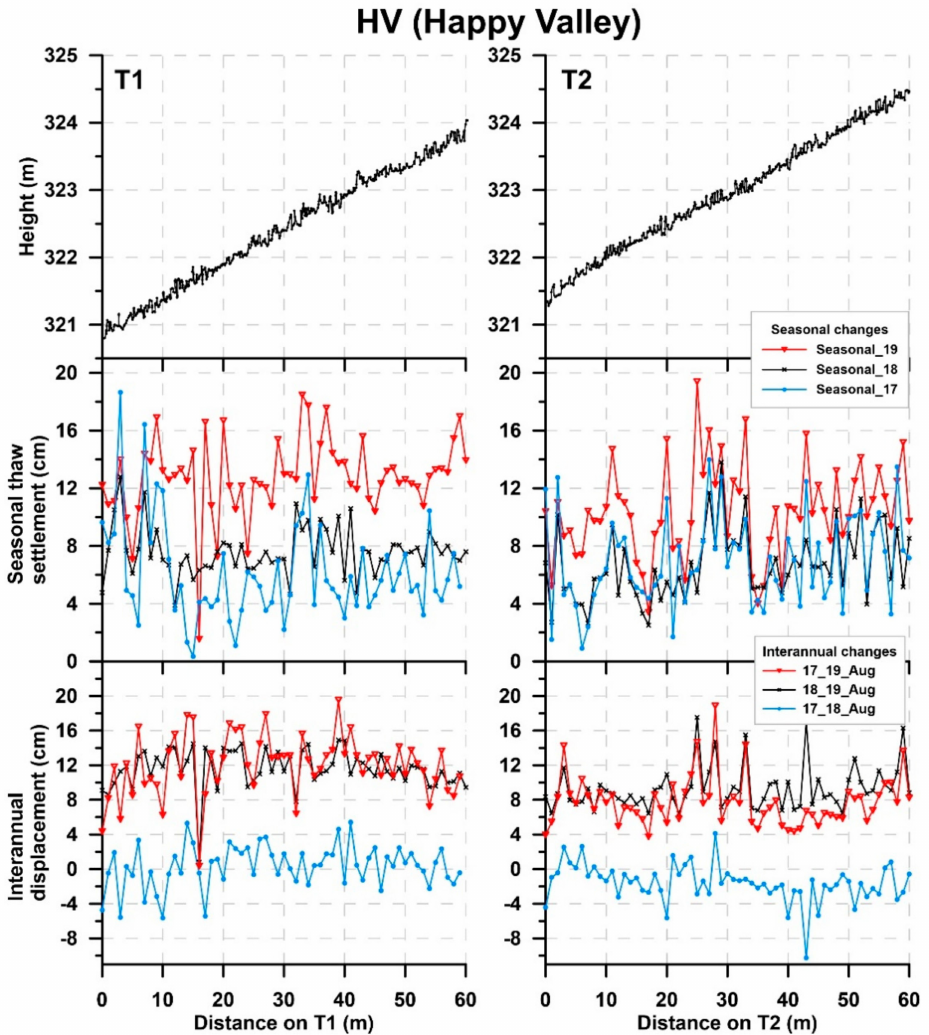
Figure 6. Microtopography in ellipsoid height (top), seasonal thaw settlement (middle), and in- terannual displacement at site HV. The heights of ground surface at survey stakes were measured on 29–30 May and 17–18 August in 2017, 2–3 June and 10–11 September in 2018, and 30 May and 20 August in 2019. Legends for the plots are the same as in Figure